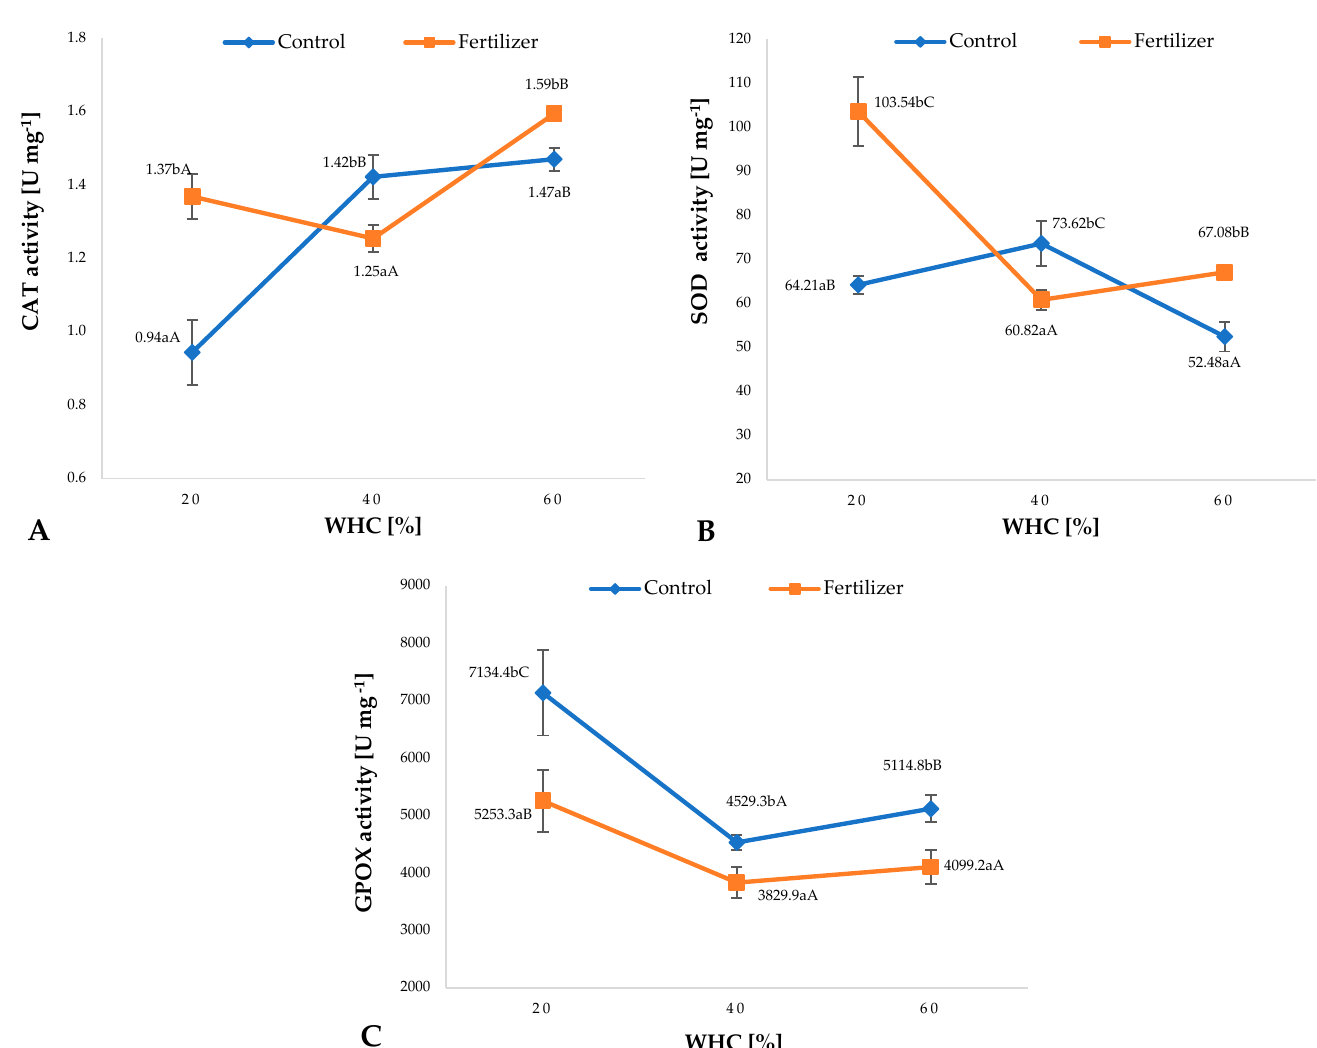
Figure 3. SOD ( A ), CAT ( B ), and GPOX ( C ) activity in maize leaves in relation to whether fertilizer was applied and to WHC [%] ( n = 20) . Significant differences between the results for enhanced and non-enhanced plants growing in soils with the specific water holding capacity are marked with small letters according to the t -Test ( p < 0.05). Significant differences in the results for the various water holding capacity values are marked with capital letters according to the Tukey’s test ( p < 0.05).